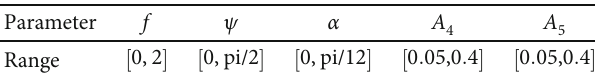
Table 4: Constraint parameters.